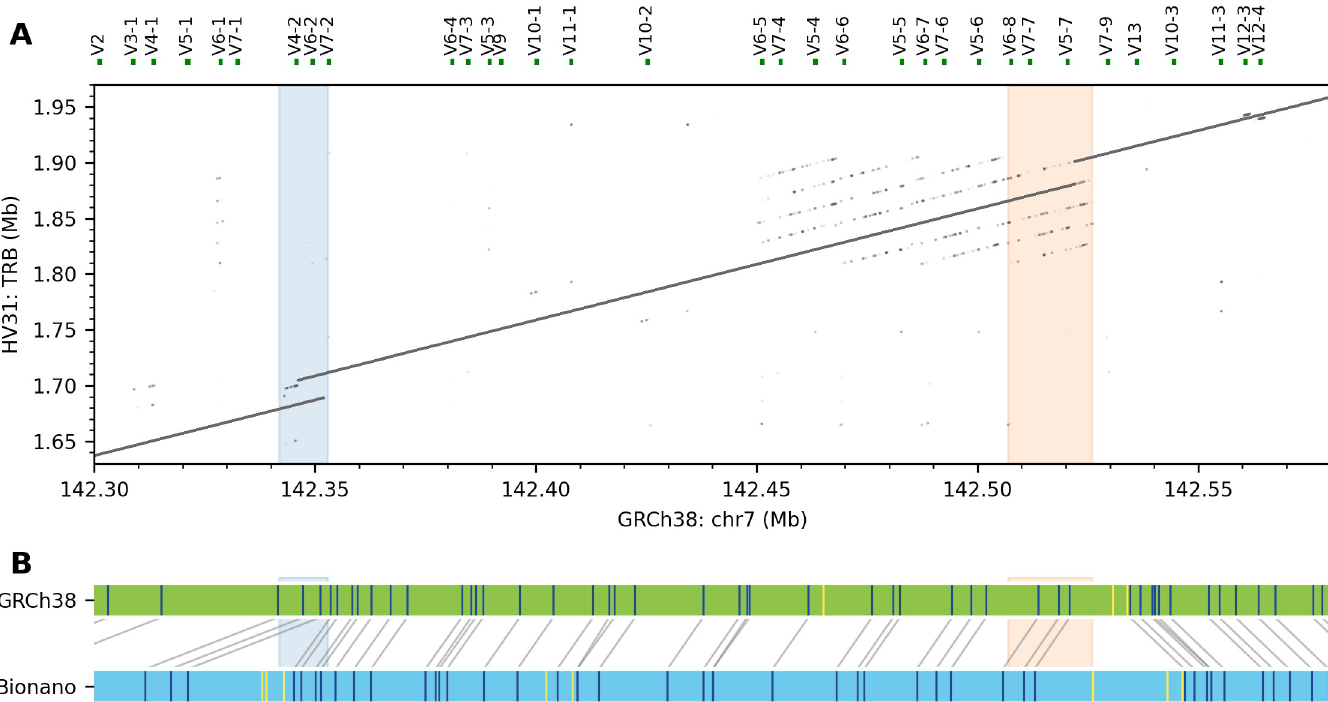
Fig 6. Large insertions in the TRB region. (A) HV31 harbors a 11 kb insertion (blue) and another 19 kb insertion (green) relative to GRCh38. (B) A Bionano contig (blue) aligned to GRCh38 (green), confirming the two insertions in (A).